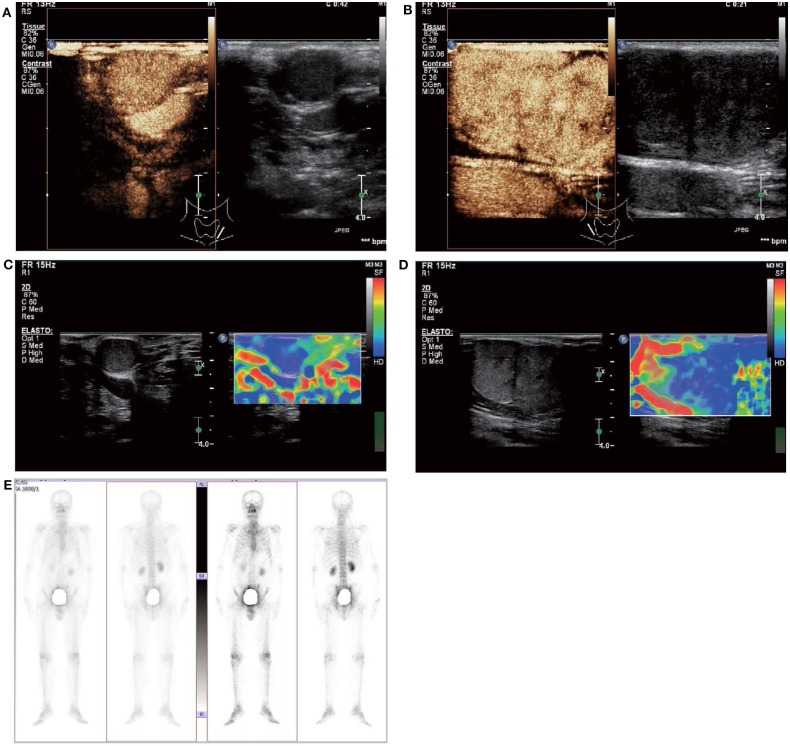
Contrast-enhanced ultrasound and elastosonography appearance of the larger subcutaneous nodules on the bilateral neck. (A,B) Contrast-enhanced ultrasound showed both the larger nodule in the bilateral neck are hypervascular, heterogeneous enhancement, no ring enhancement, and partially clear enhanced boundary. (C,D) Elastosonography displayed both the larger one were mainly composed of blue color (at least 75% of the nodule was covered in blue). (E)
99mTcO4-SPECT whole body scan was performed and showed no abnormal uptake in the whole body.